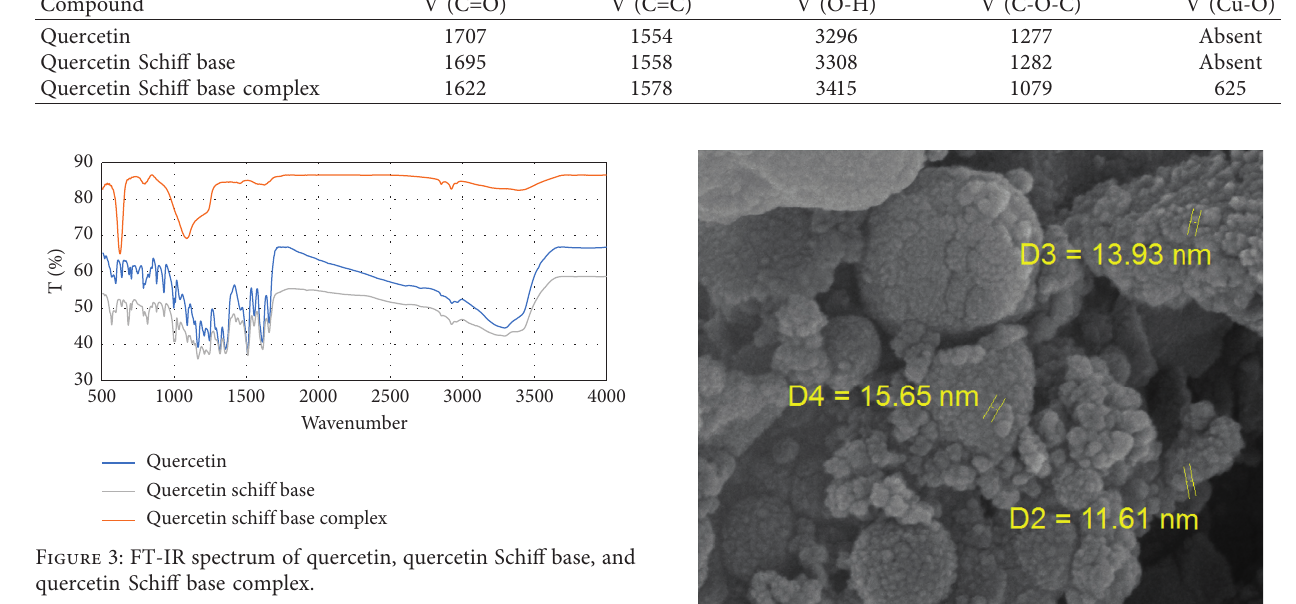
Table 3: Comparison of main peaks in quercetin, quercetin Schiff base, and quercetin Schiff base complex. Compound